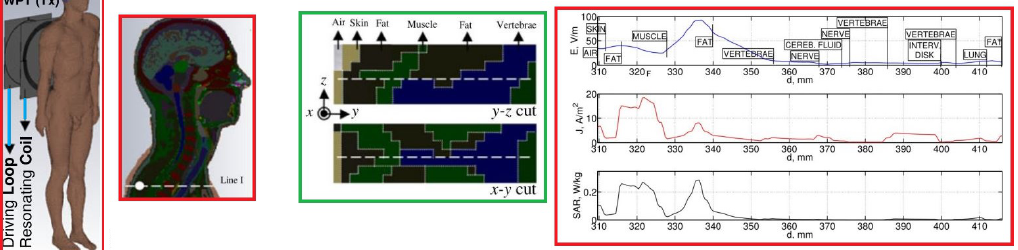
Figure 17. The exposure scenario with Tx part of a WPT system in proximity to the Duke human body model showing the distribution of E, J, and SAR inside the model along line I.